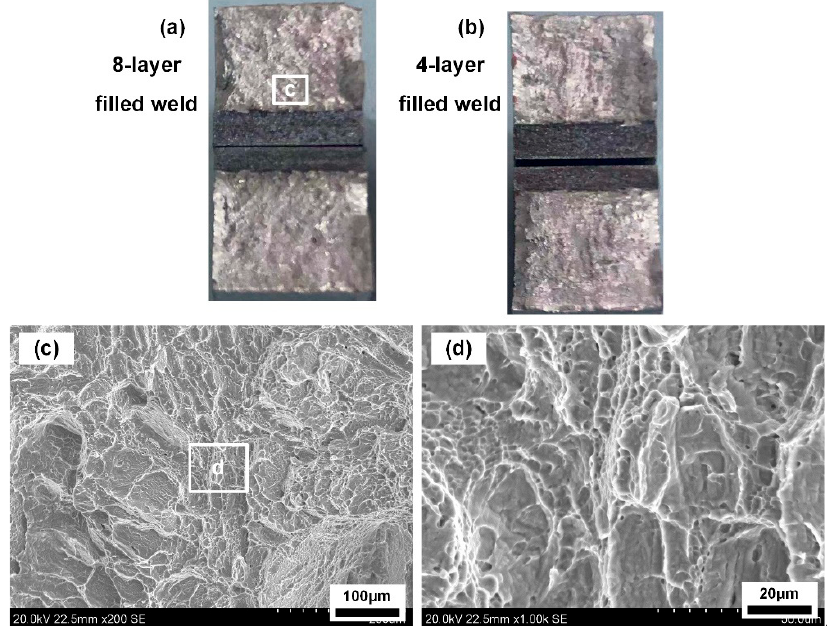
Figure 10. Impact toughness results of different welds at 20 °C and − 50 °C.